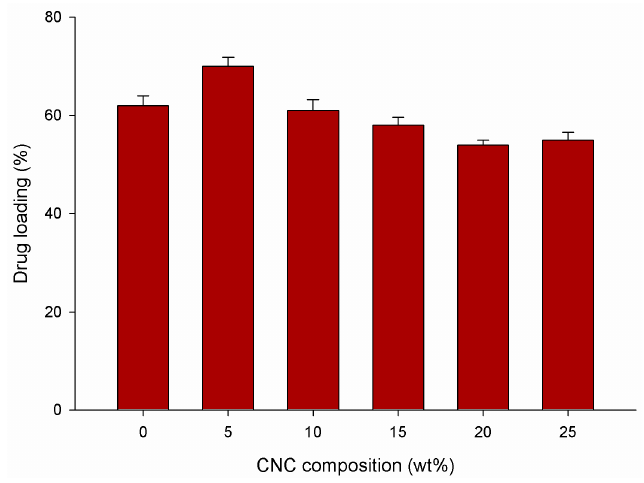
Figure 7. Drug loading (%) on the hydrogel at varying CNC composition.